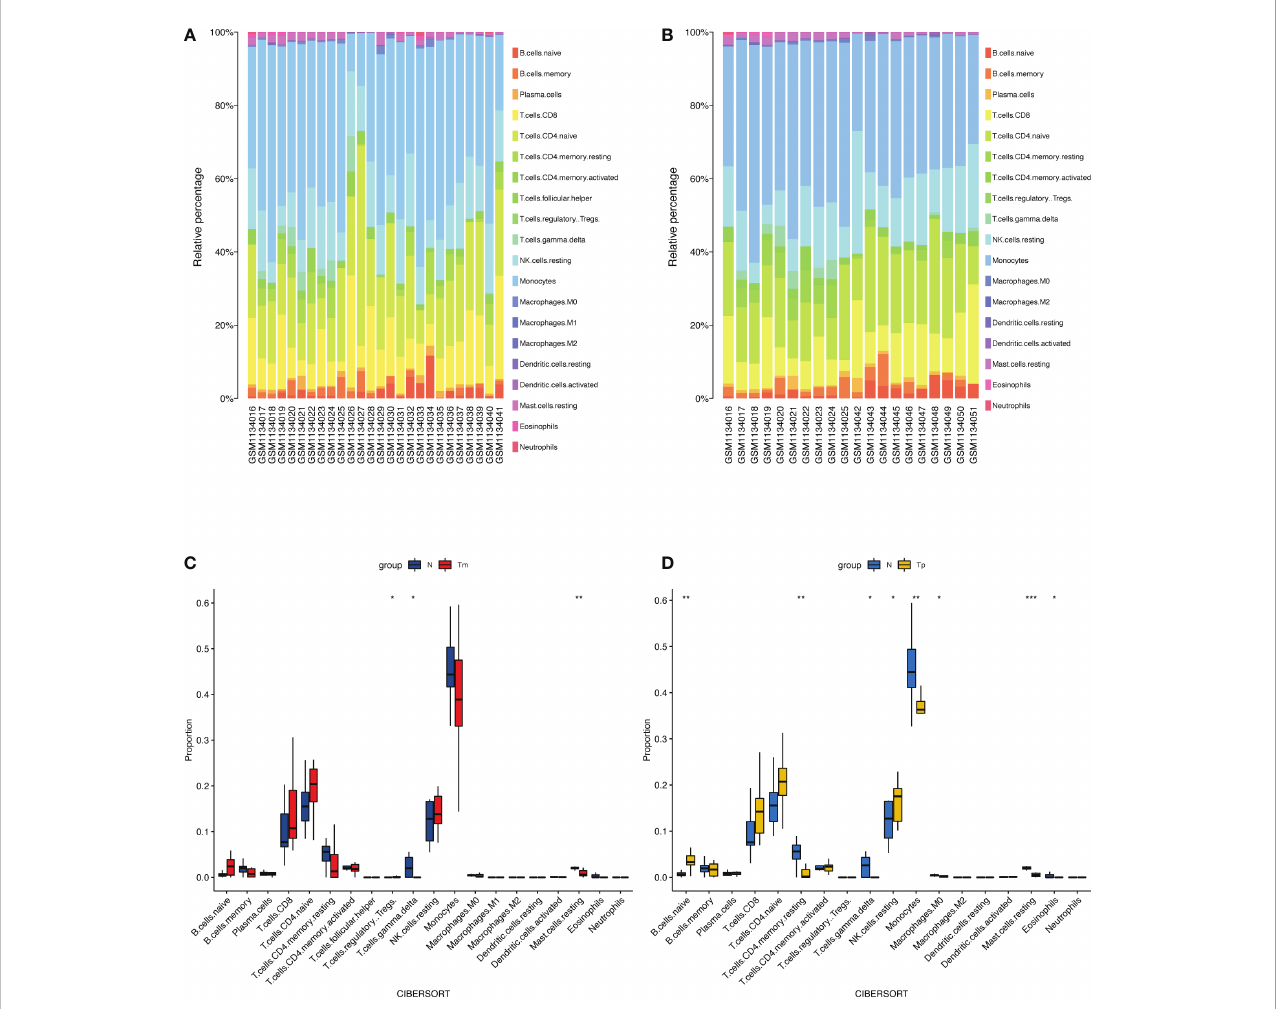
FIGURE 6 The landscape of immune in fi ltration between monosomy X TS patients and normal individuals. (A) The relative percentage of immune cells in Xm TS patients, and normal individuals. The fi rst 10 samples were normal individuals, the rest were Xm TS patients. (B) The relative percentage of immune cells in Xp TS patients, and normal individuals. The fi rst 10 samples were normal individuals, the rest were Xp TS patients. (C) The differences in immune cell proportions between Xm TS patients (red color) and the normal individuals (blue color). (D) The differences in immune cell proportions between Xp TS patients (yellow color) and the normal individuals (blue color). (* p < 0.05,** p < 0.01,*** p <